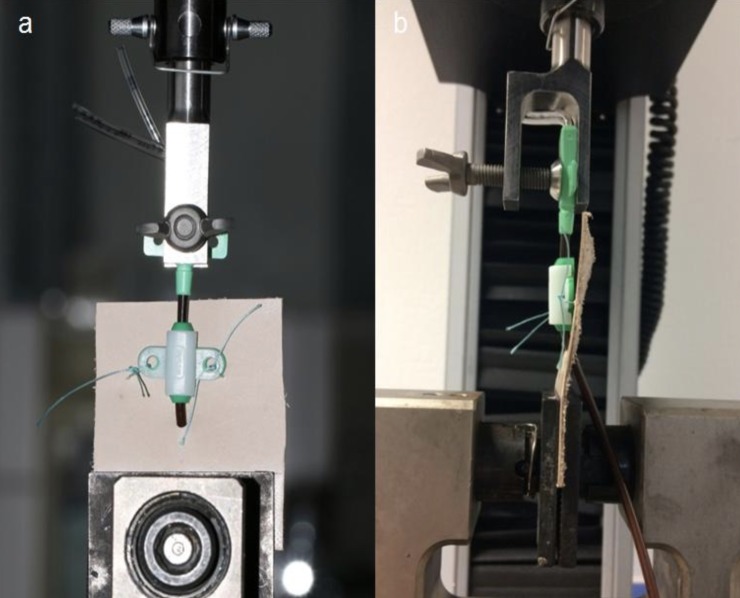
Test setting.Anterior view (a) and lateral view (b) of the sutured central venous catheter unit mounted on the tensile testing machine.